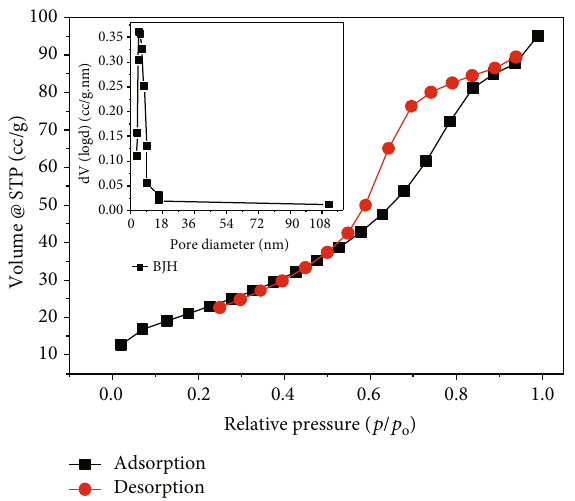
Figure 5: Adsorption-desorption measurements showing BJH plot (inset: pore size distribution).